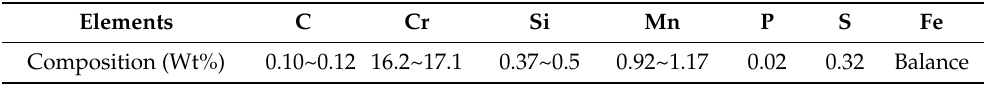
Table 1. Chemical composition of AISI430 ferritic steel sample.